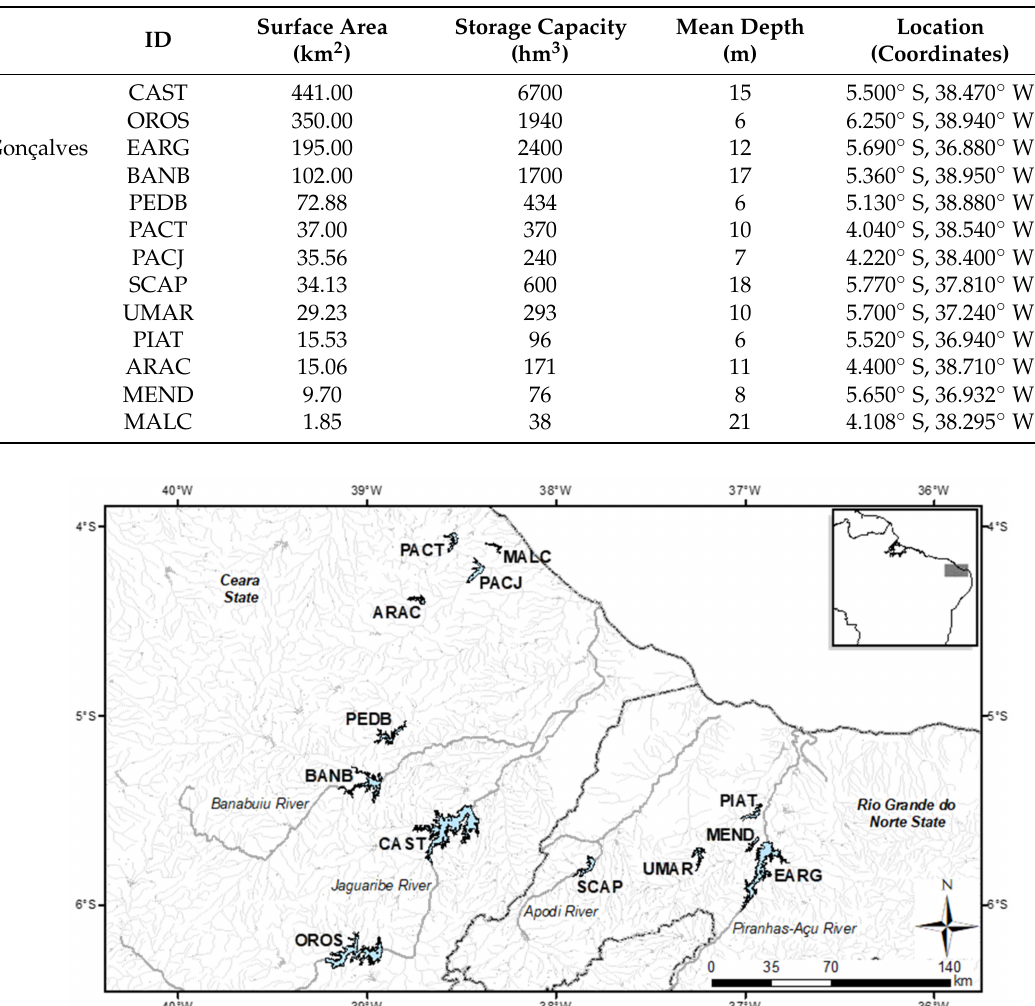
Figure 1. Location of the 13 study lakes (Table 1) in the Brazilian semiarid region (Cear á and Rio Grande do Norte